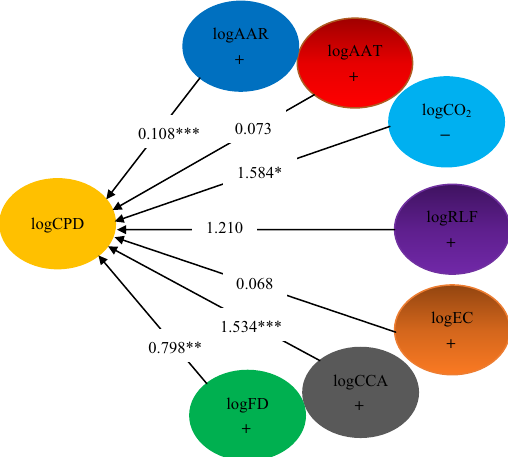
Figure 4. Summary of the long- term relationship between the variables